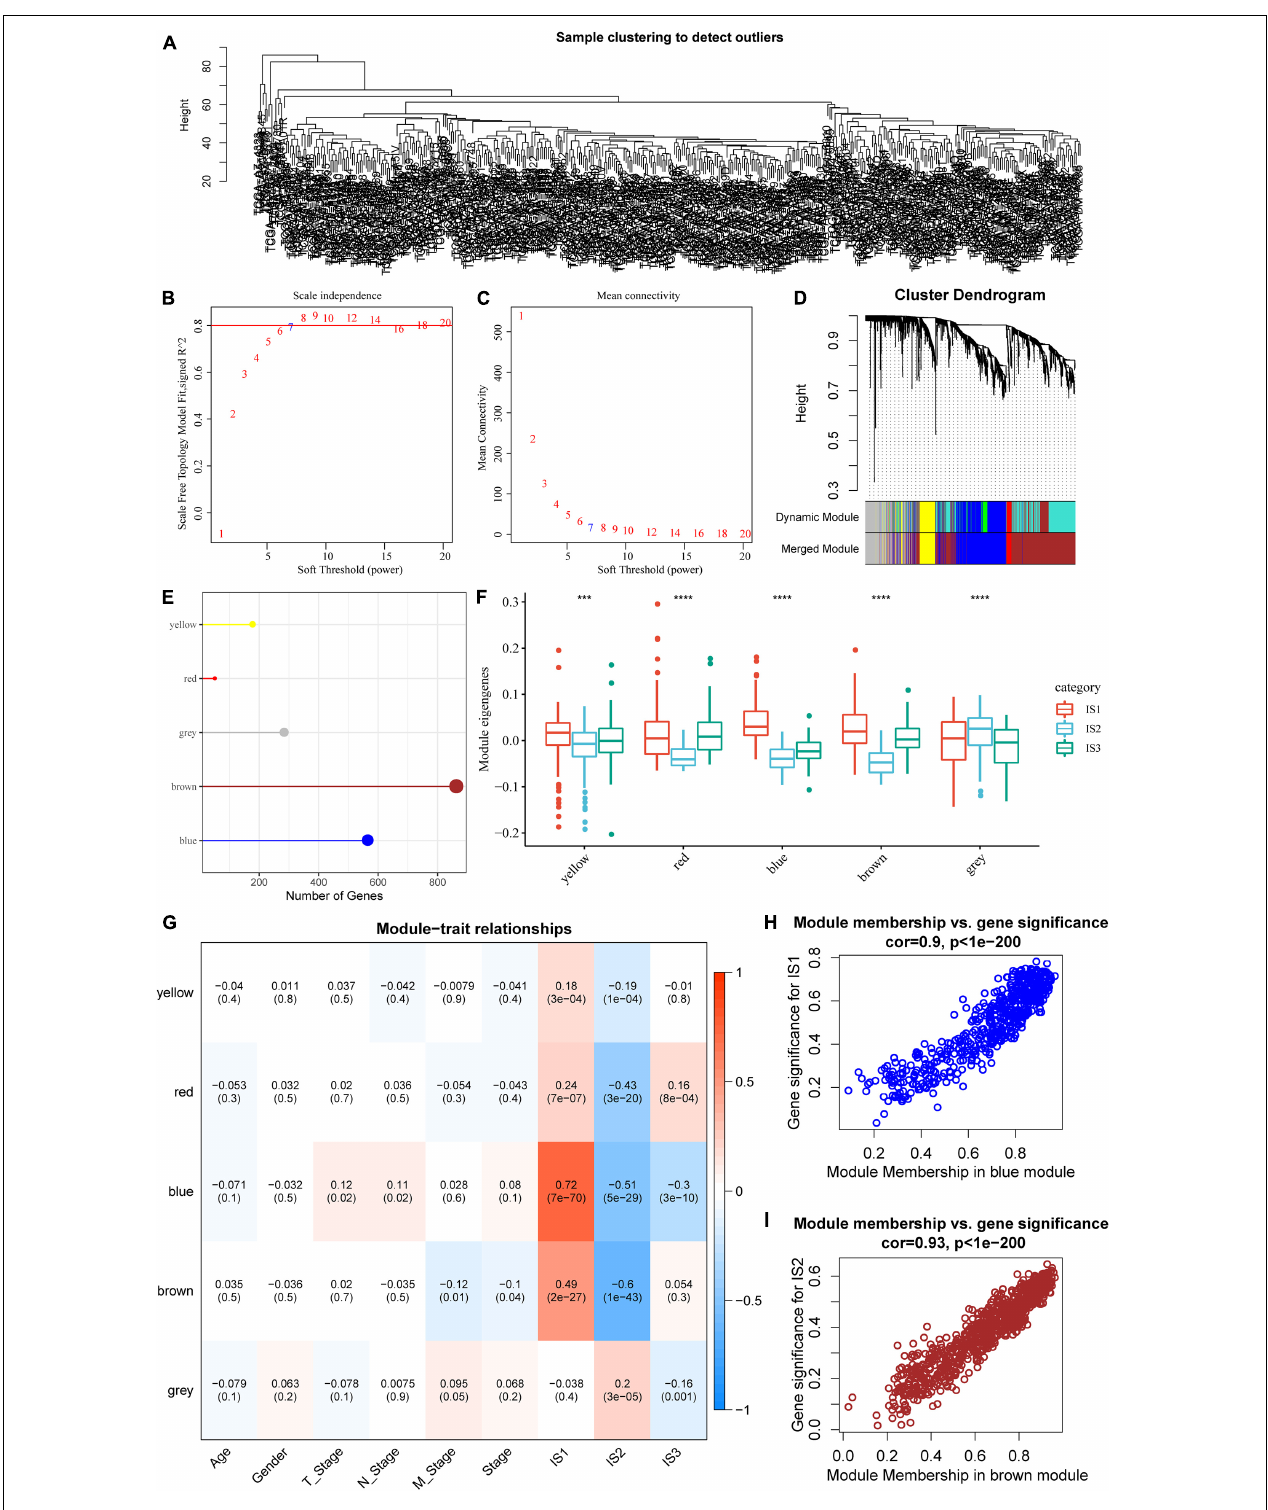
FIGURE 8 | Co-expression module analysis of immune genes. (A) Sample cluster analysis; (B,C) Analysis of network topology for various soft-thresholding powers; (D) Gene dendrogram and module colors; (E) Gene statistics of modules; (F) Distribution of modular eigenvectors in immune molecular subtypes; (G) Correlation analysis between module feature vector and clinical features; (H) Scatter diagram for the module membership vs. gene significance for IS1 in the blue module; (I) Scatter diagram for module membership vs. gene significance for IS2 in the brown module. *** P < 0.001 and **** P < 0.0001.